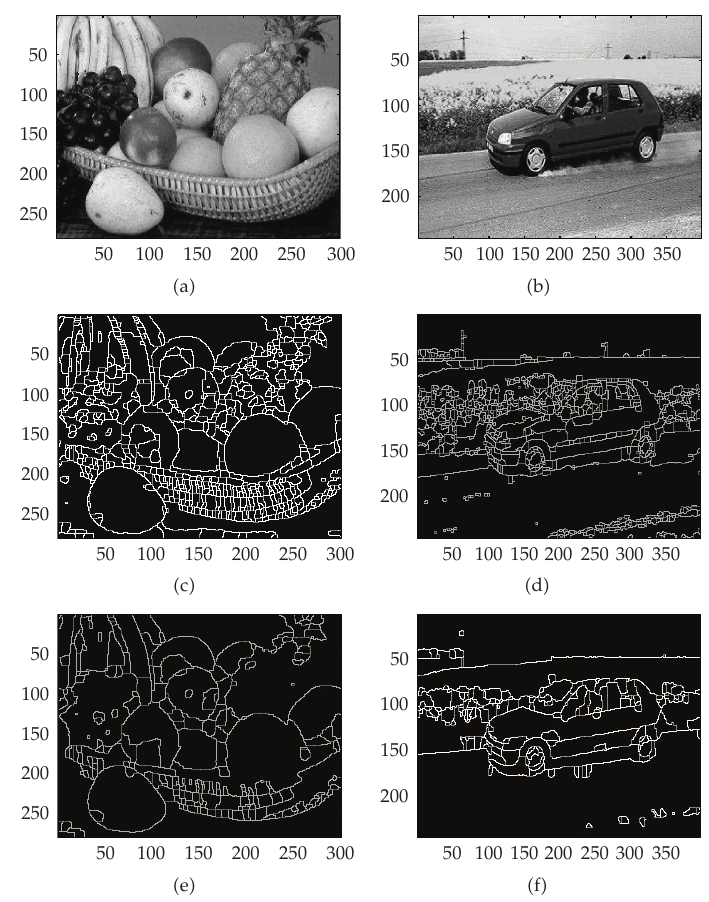
Figure 8: Segmentation using a watershed transformation combined with the topological gradient: (cid:7) a (cid:8) is a 302 × 280 fruit-basket gray level image, (cid:7) b (cid:8) is a 399 × 246 road scene image, (cid:7) c (cid:8) is the segmented fruit-basket image with c (cid:10) 1, (cid:7) e (cid:8) is the same segmented image such that c (cid:10) 50, (cid:7) d (cid:8) is the segmented road scene image with c (cid:10) 1, and (cid:7) f (cid:8) represents the same segmented image such that c (cid:10)